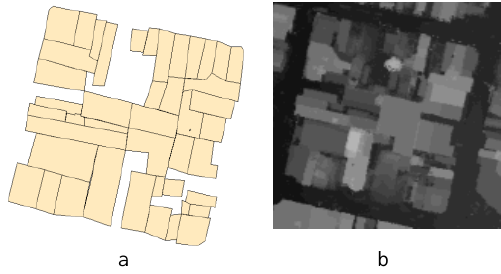
a b Fig.4. The study area (a) vector map (b) LiDAR data